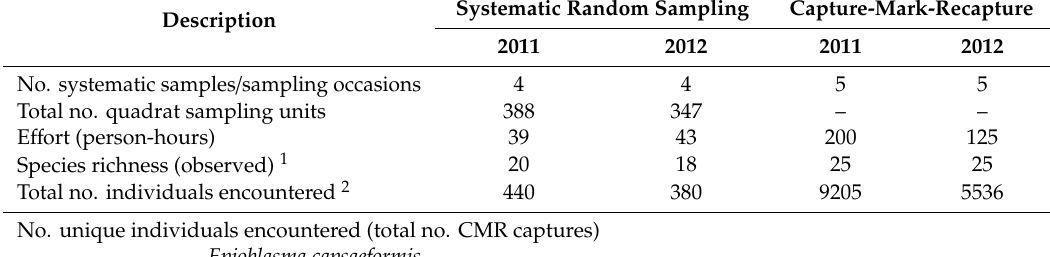
Table 2. Summary of systematic random quadrat and capture-mark-recapture (CMR) sampling e ff orts in 2011 and 2012 at Cleveland Islands in the Upper Clinch River, Russel County, Virginia.